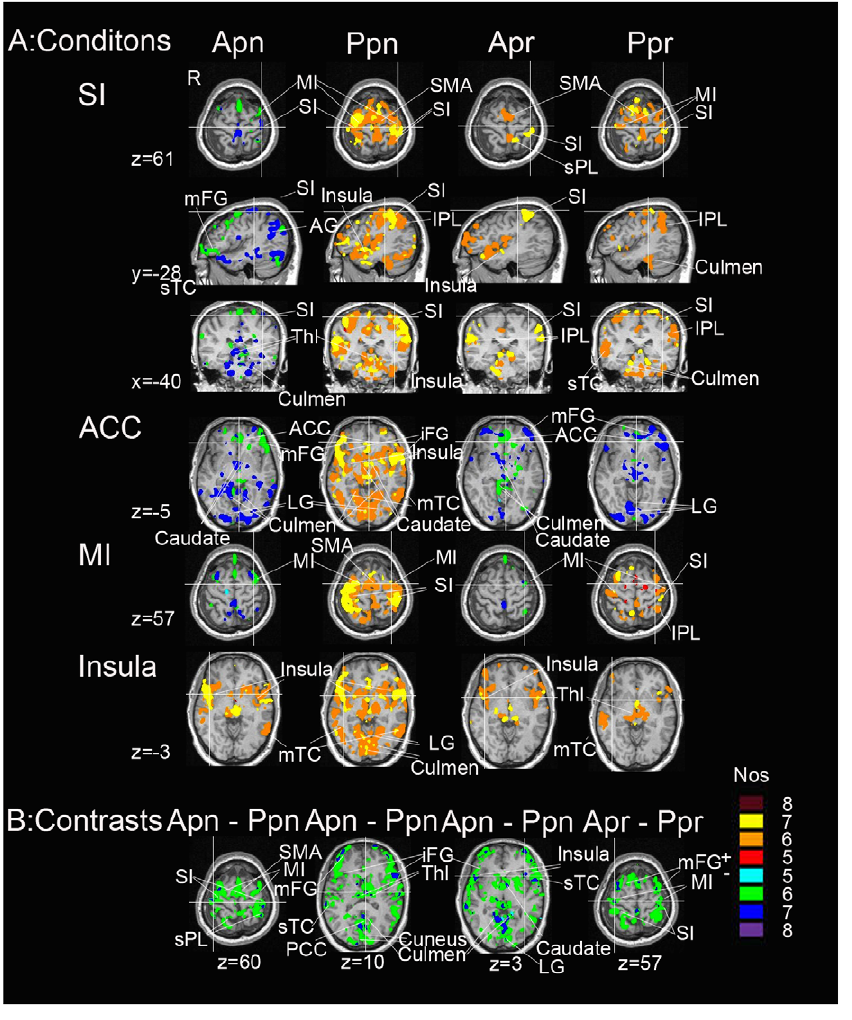
Figure 2. Regional brain activation in the conjunction analysis. A) Activation maps in the four conditions. Panels shown from left to right: active pain (apn); passive pain (ppn); active pressure (apr); passive pressure (ppr). The first three rows display the activation of SI, and the fourth to sixth rows show the activation of ACC, MI, insula in sequential order. B) Differences between pairs of conditions. The left three panels: active minus passive pain. The most right panel: active minus passive pressure. Nos, number of subjects. + : activation; 2 : deactivation. All data were corrected, p , 0.05. R stands for right. SI, primary somatosensory cortex; MI, primary motor cortex; SMA: supplementary motor area; mFG, middle frontal gyrus; sTC: superior temporal cortex; Thl: thalamus; ACC, anterior cingulate cortex; AG: angular gyrus; LG, lingual gyrus; mTC, middle temporal cortex; iFG: inferior frontal gyrus; IPL: inferior parietal lobule; sPL: superior parietal lobule; PCC, posterior cingulate cortex.